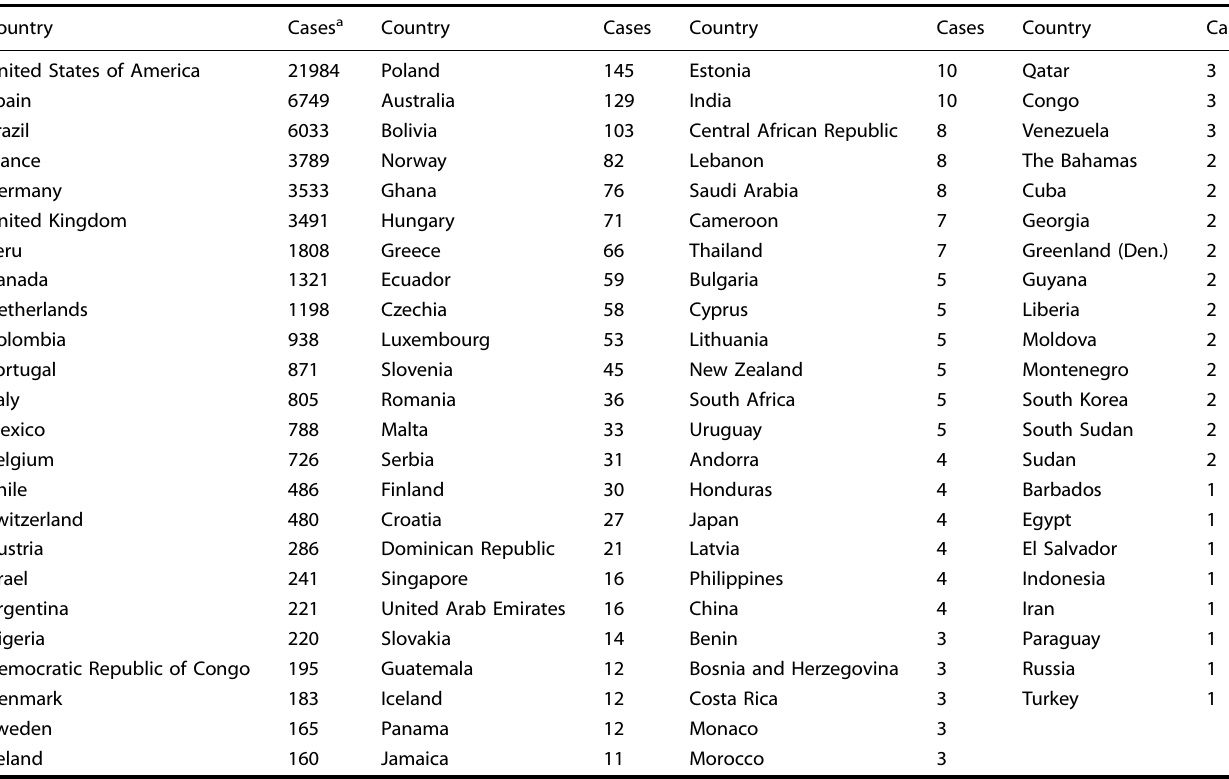
Table 1. 2022 monkeypox global